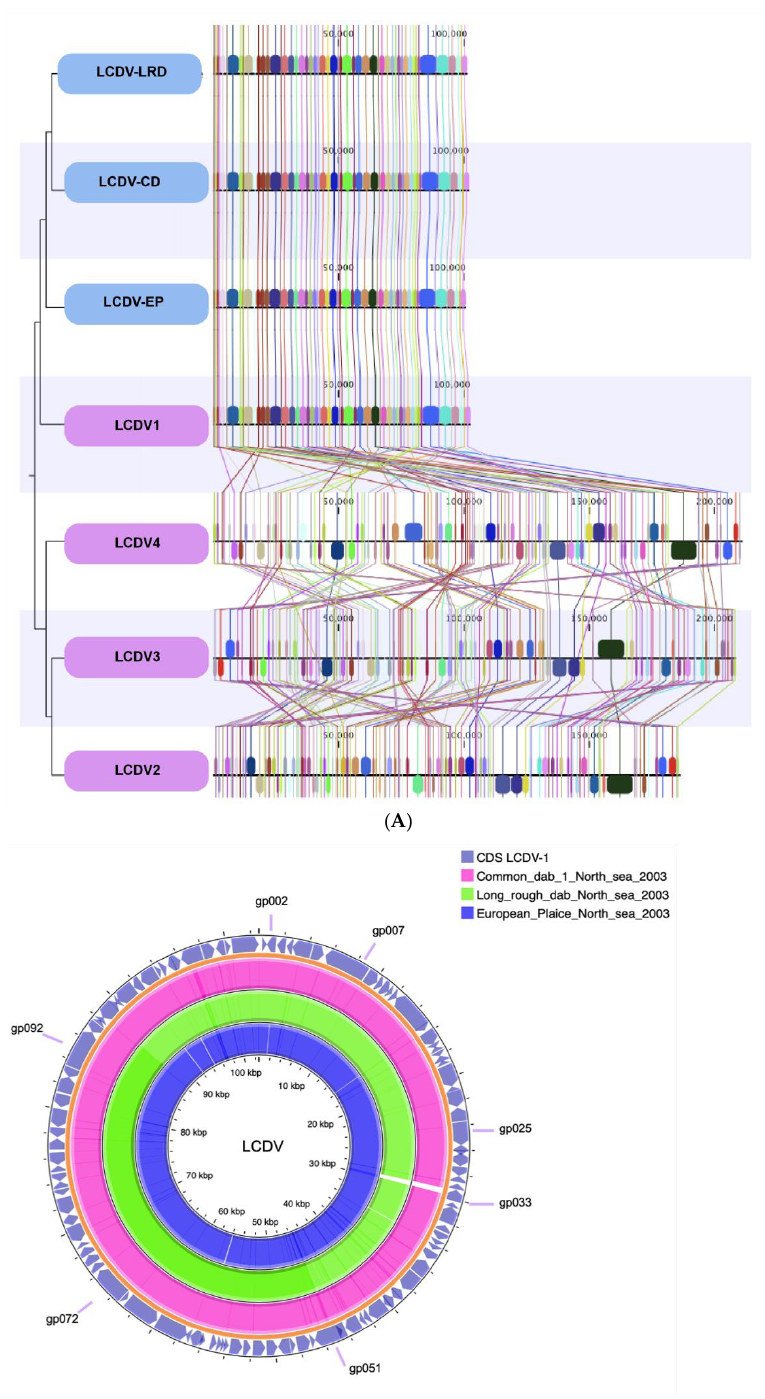
Figure 2. ( A ) Comparative MAUVE alignment of LCDV1, LCDV2, LCDV3 (LCDV-C), LCDV3, and LCDV4, and three LCDV complete genomes of LCDV-EP (European plaice), LCDV-LRD (Long rough dab), LCDV-CD (Common dab). Vertical coloured lines and blocks show the conservation of genomic regions across the genomic sequences. ( B ) Obtained LCDV genome sequences aligned to the virus species LCDV1 in a circular manner.